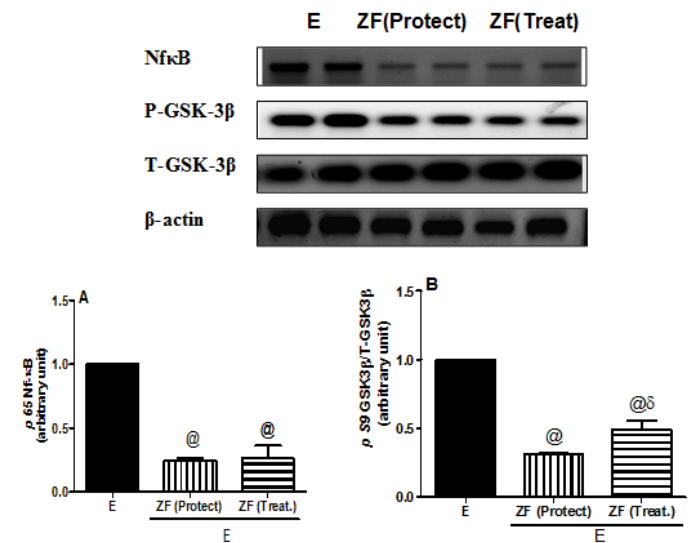
FIGURE 6 - Intratumoral protein expression of p-(S9) GSK-3β and p 65